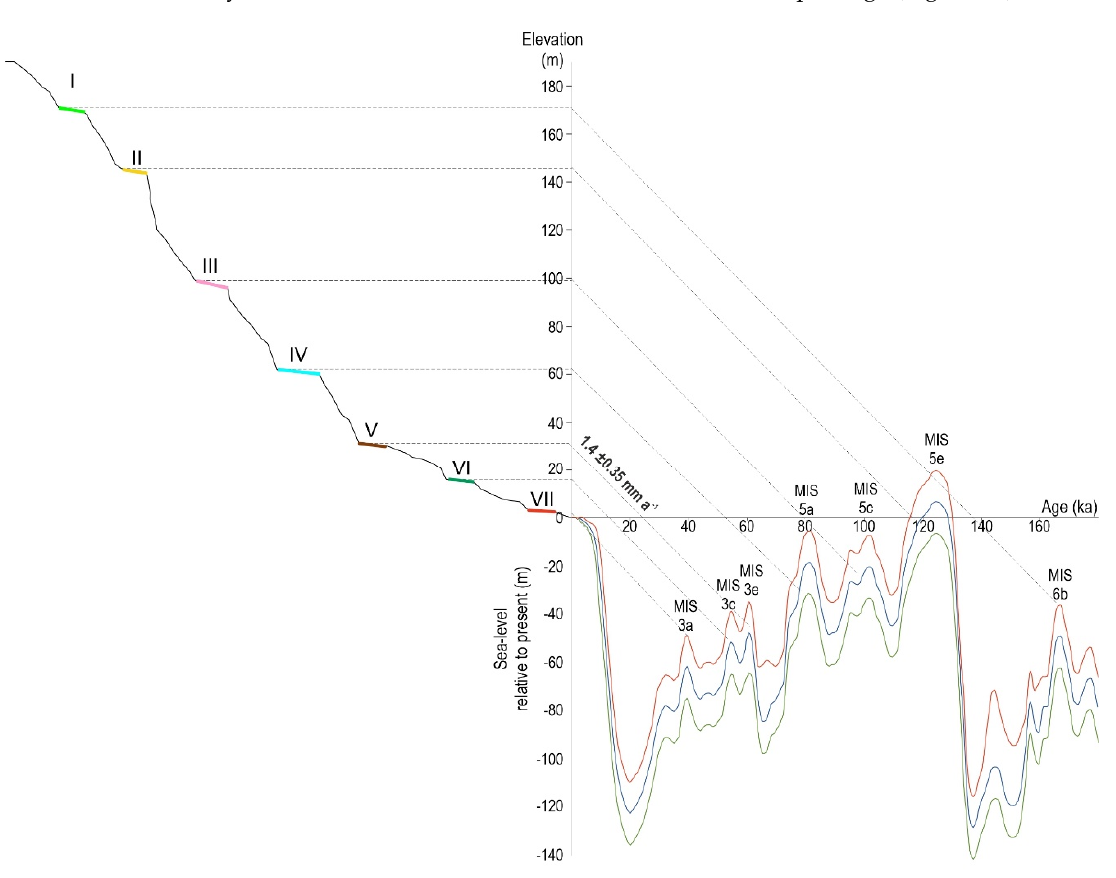
Figure 11. Potential correlation of the marine terraces on the southern part of the main Cephalonia Island with highstands (MIS) of the sea-level curve derived by [15]. The red, blue and green lines correspond to a maximum, mean and minimum sea level, respectively.